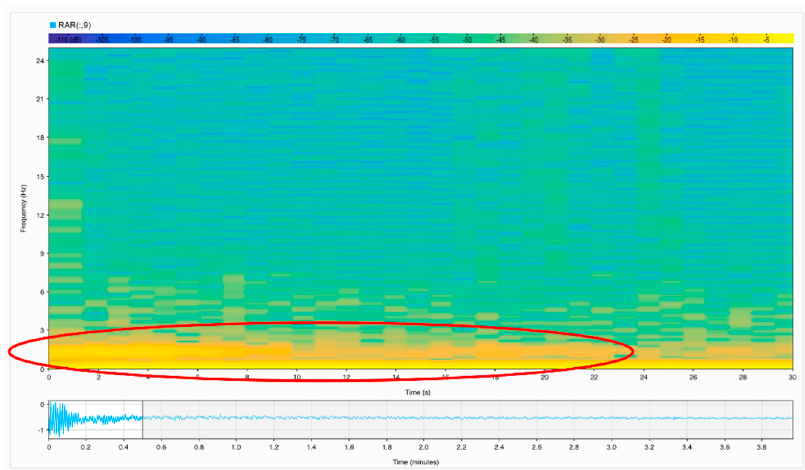
Figure 17. RAR signal spectrogram; 1.33Hz frequency in the red ellipsis.